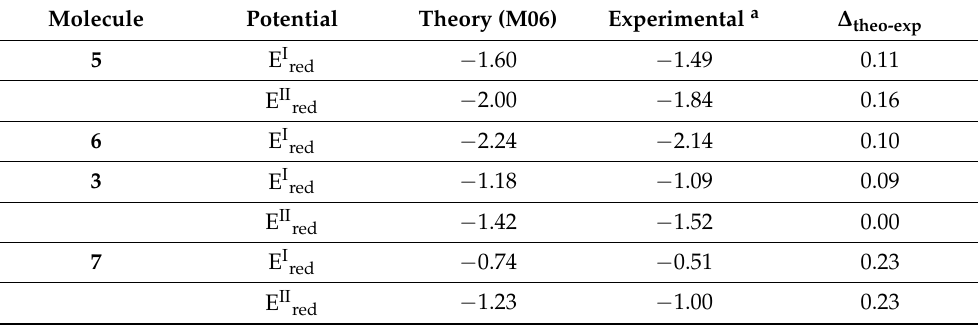
Table 3. Reduction potentials (V) for studied compounds computed by using the M06/6–31+G* level of theory. The used theoretical and experimental solvents are 5 and 6 in tetrahydrofuran; 3 and 7 in dichloromethane. a from refs [41,72,74,75]. Molecule Potential Theory